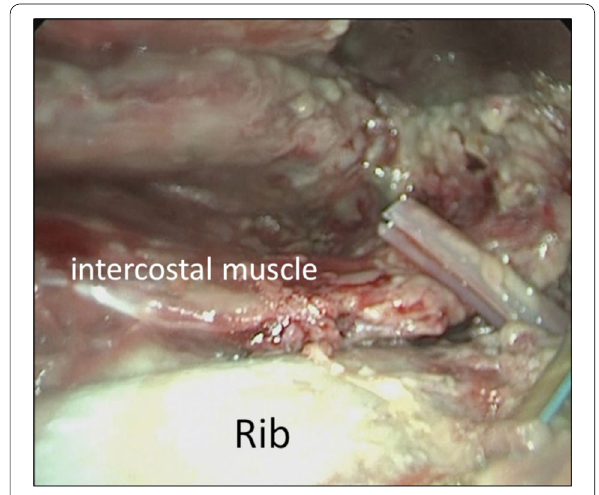
Fig. 2 Adhesion of the pus can be clearly observed between the intercostal and serratus anterior